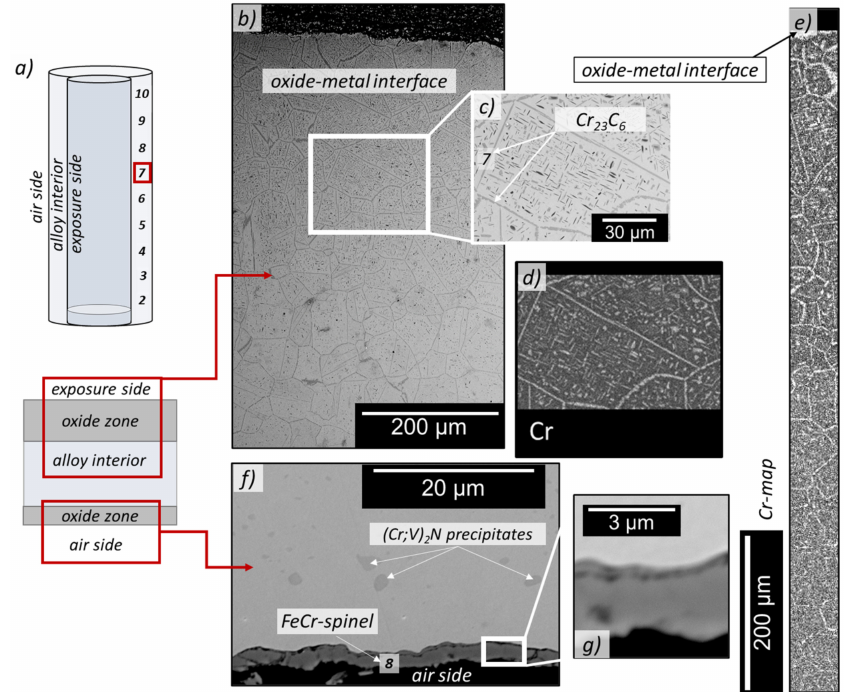
Figure 6. ( a ) Sketch for the sample position in the vessel and cross-section partitioning, ( b ) cross- section BSE images of sample #7 from the exposure side (( b – e ) images). ( c ) Environmentally induced intra- and intergranular precipitation, ( d ) EDS chromium element map in one grain isolated, ( e ) EDS chromium element map starting from the metal–oxide interface showing deep carburization induced precipitation on the exposure side of the vessel. ( f , g ) BSE images from the air side of the vessel. The Fe-Cr spinel oxide is only 2 µ m thick on average.